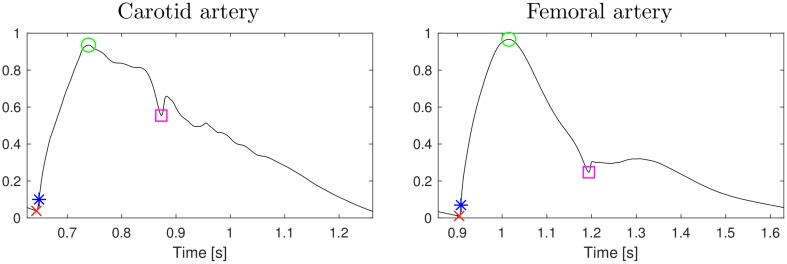
Two example pulses with the considered timings marked: the minimum/foot (PTTff; red cross), the maximum (PTTp; green circle), the maximum of the first derivative (PTTD; blue star), and dicrotic notch (DAT; magenta square).